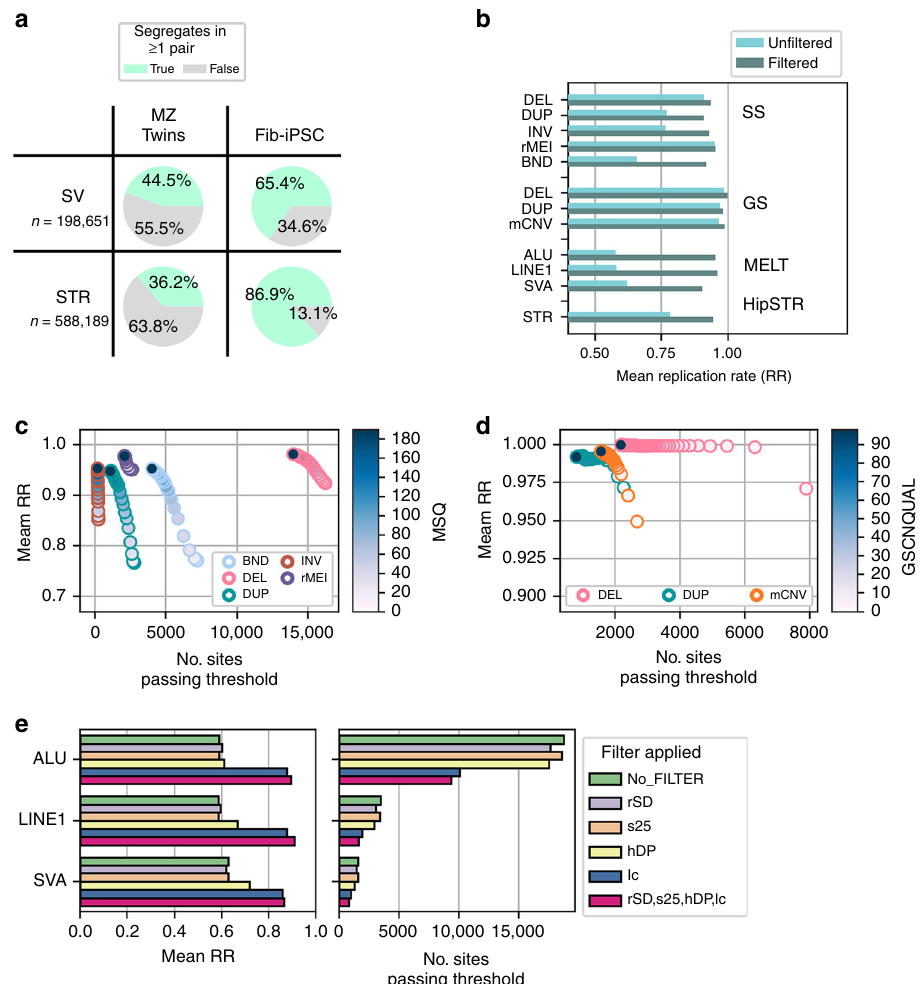
Fig. 2 Replication rate is associated with reported quality metrics. a Proportion of SVs and STRs that were non-reference (green) in at least one of the iPSCORE MZ twin pairs or HipSci fi broblast – iPSC pairs prior to fi ltering. b Replication rate of variants before and after fi ltering and deduplicating within caller; Genome STRiP and SpeedSeq abbreviated in fi gure as GS and SS respectively. c Replication rate in MZ twins versus the number of total SpeedSeq (LUMPY) sites remaining that pass criteria when fi ltering variants to different thresholds for MSQ score (indicated by color). d Replication rate versus the number of total Genome STRiP sites remaining that pass criteria when fi ltering variants to different thresholds for GSCNQUAL score (indicated by color). e Replication rate in MZ twins for MELT sites that pass criteria when fi ltering variants under suggested hard site fi lters (left). Pink represents the result of fi ltering using all four exclusion criteria (rSD, s25, hDP, lc; see Methods). The number of total sites remaining that passed criteria is shown at